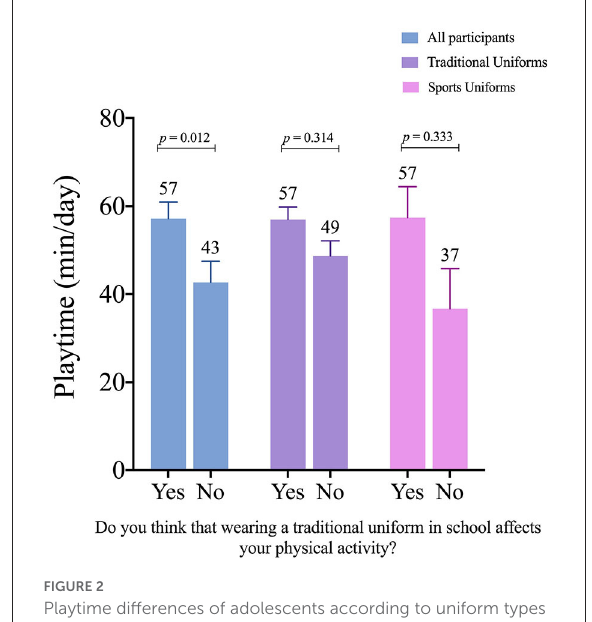
FIGURE2 Playtime differences of adolescents according to uniform types and perception of traditional uniform affecting their physical activity. Estimated marginal means and standard error. P -value adjusted for multiple comparisons (Holm correction). Figure according to model 2 (adjusted for sex, PHV, BMIz, physical fitness, and SVI).